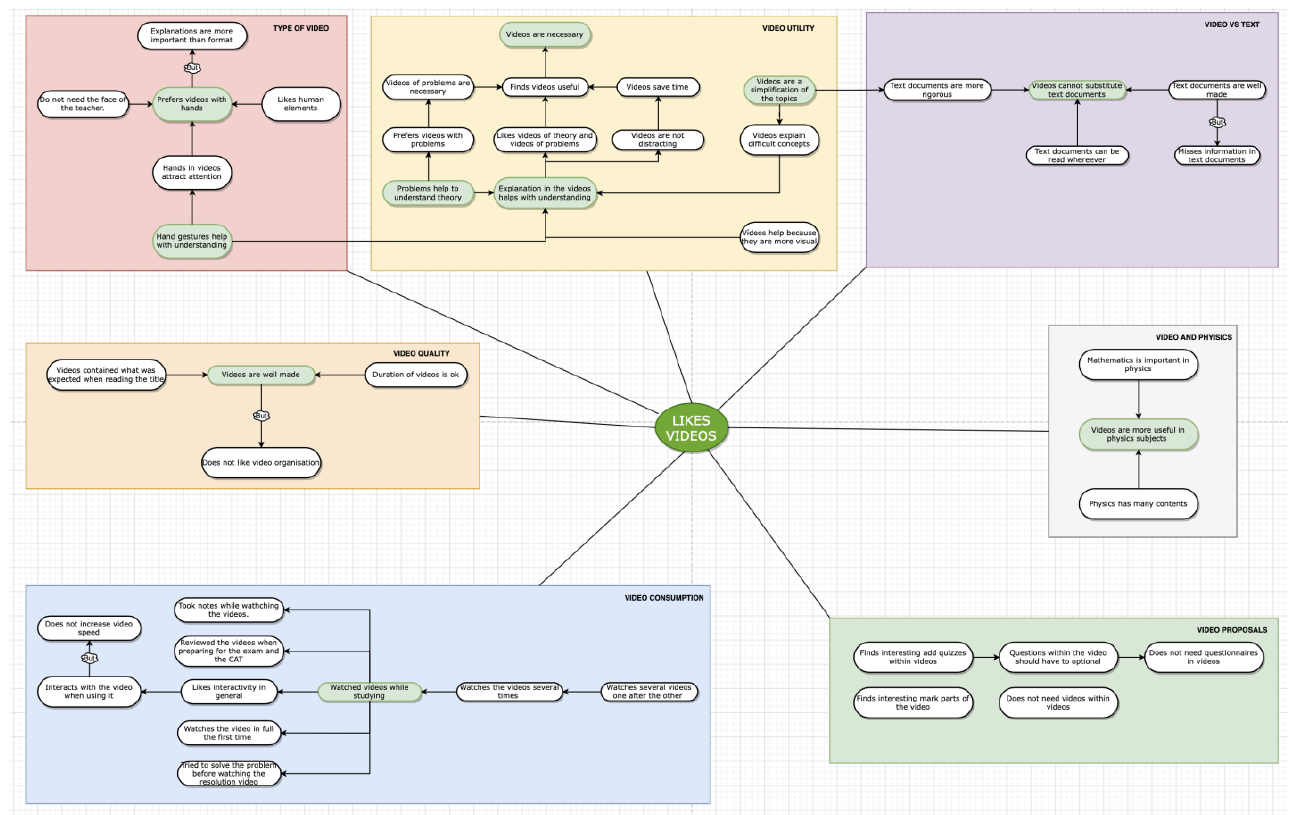
Figure 3. Conditional/causal matrix between codes related with video perception. Green nodes represent those where several arrows come in and out.